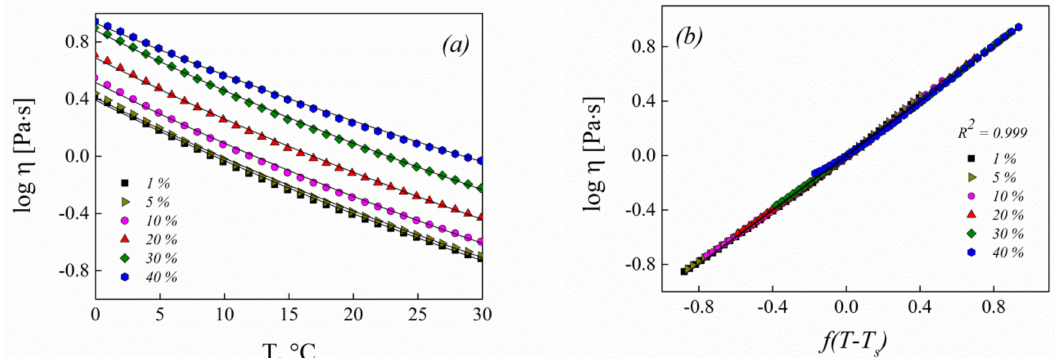
Figure 6. ( a ) Temperature dependence of w/o emulsions viscosity obtained at cooling rate of 1 K/min . γ and = 50 s − 1 . Concentration of emulsions is shown on the graphs. Data approximated by the Williams-Landel-Ferry (WLF) equation are shown by black lines; ( b ) Temperature dependence of w/o emulsions viscosity plotted in the WLF equation